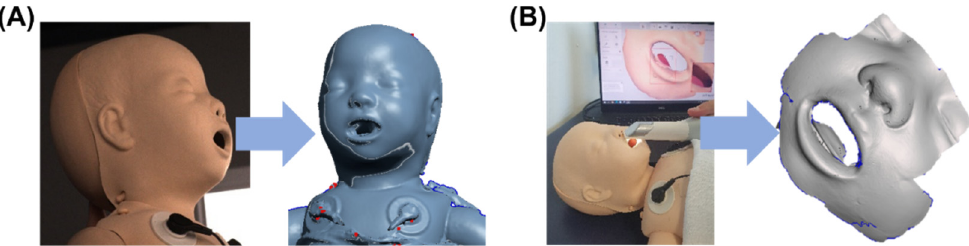
Figure 4. Facial scan of a neonatology dummy. ( A ) Process of scanning with the 3dMd facial scanner with corresponding stl. file; ( B ) Scanning with Trios3 intraoral scanner and respective stl. file.